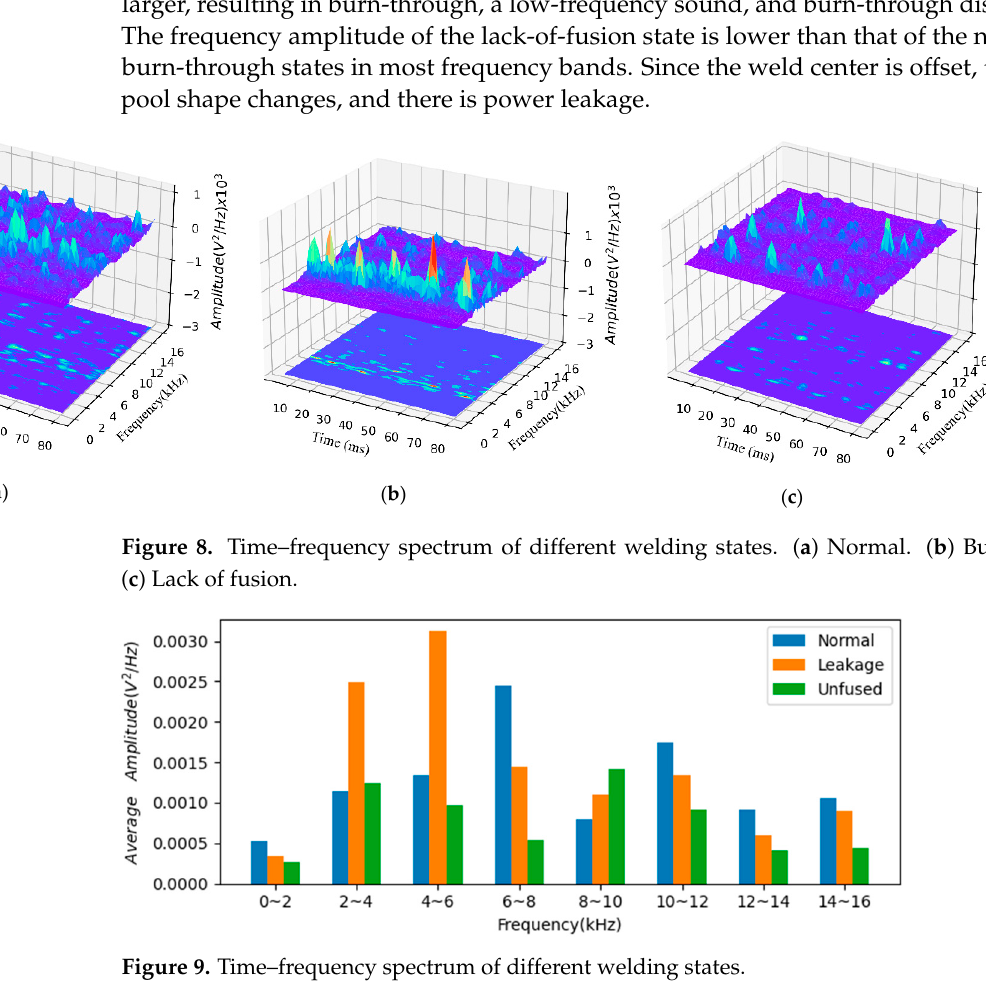
Figure 7. Time domain waveform, frequency spectrum, and time–frequency spectrum of arc sound. ( a ) Arc sound. ( b ) Frequency spectrum of arc sound. ( c ) Time-frequency spectrum of arc sound.